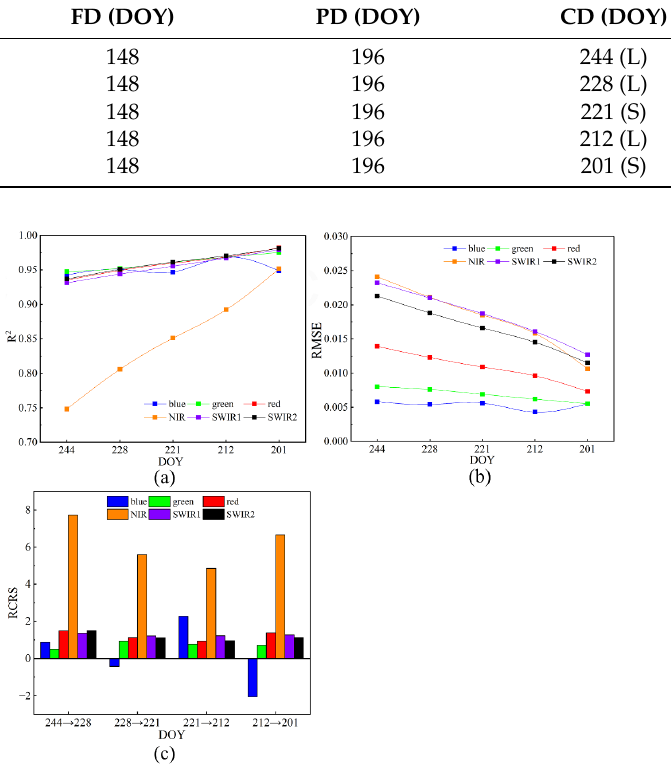
Figure 6. Accuracies of the fused images with different CDs for the MLC period. ( a ) R 2 , ( b ) RMSE, and ( c ) RCRS (The horizontal axis indicates the DOY of the input CD image pairs for ( a , b ), and the change of DOY for ( c ); the vertical axis indicates the values of R 2 , RMSE, and RCRS, respectively).